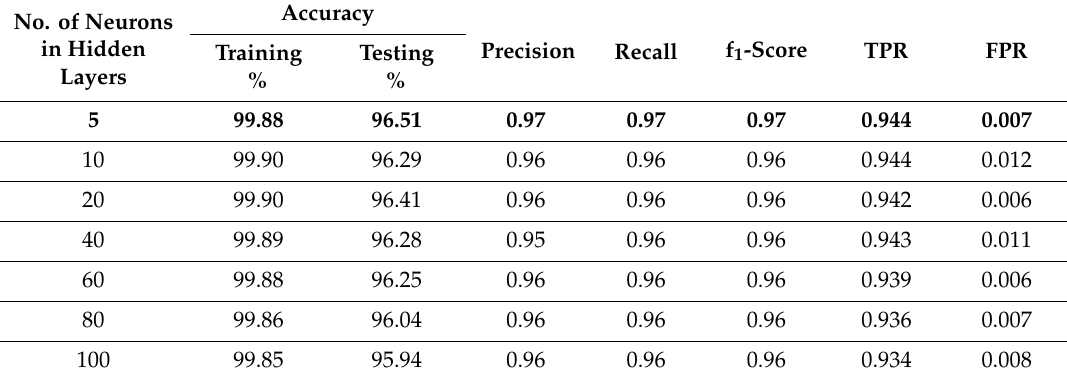
Table 6. Binary classification performance results using 122 features.